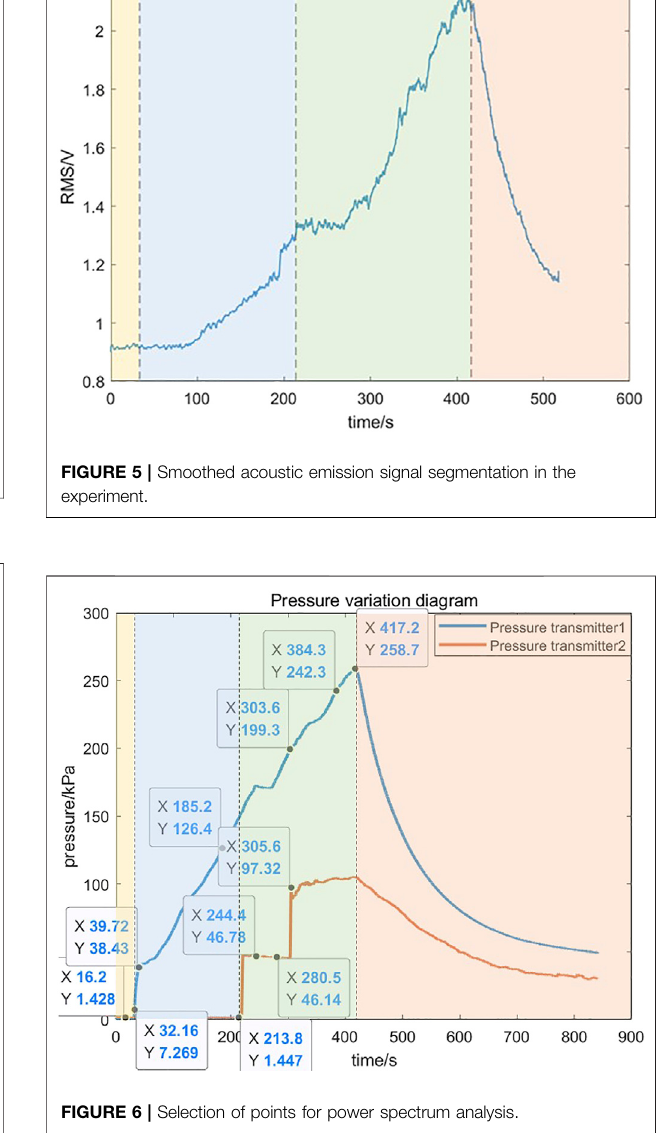
FIGURE 4 | Time-domain curve of the acoustic emission signal in the experiment.